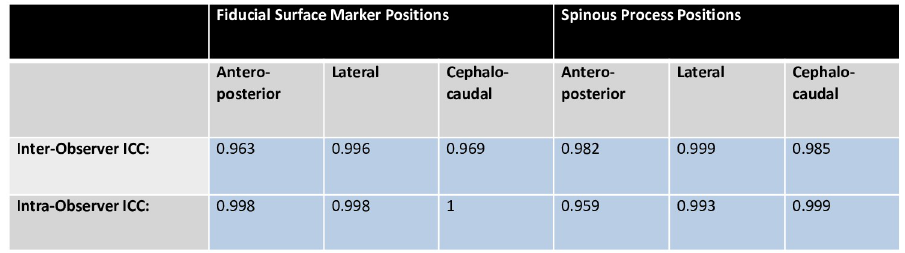
Fig 7. Intra and inter-observer reliability for fiducial surface marker and spinous process position selections. Position data was described by antero-posterior, lateral and cephalo-caudal coordinates, which were each assessed for reliability by calculating ICC. ICC greater than 0.81 describes almost perfect agreement